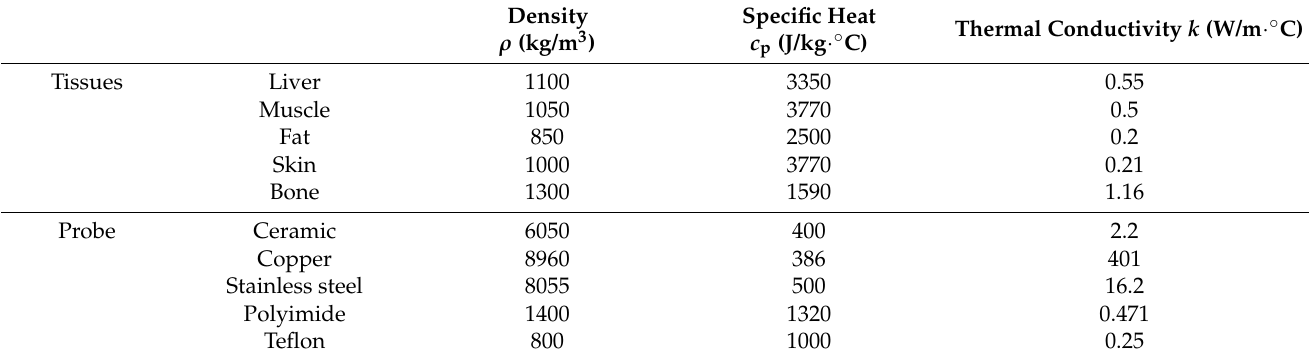
Table 1. Thermophysical properties for the solid materials